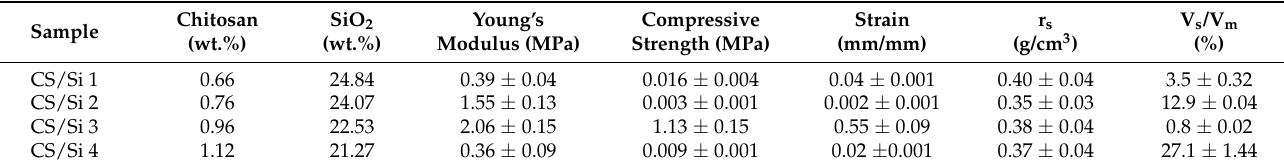
Table 1. Properties of references samples of CS/Si.